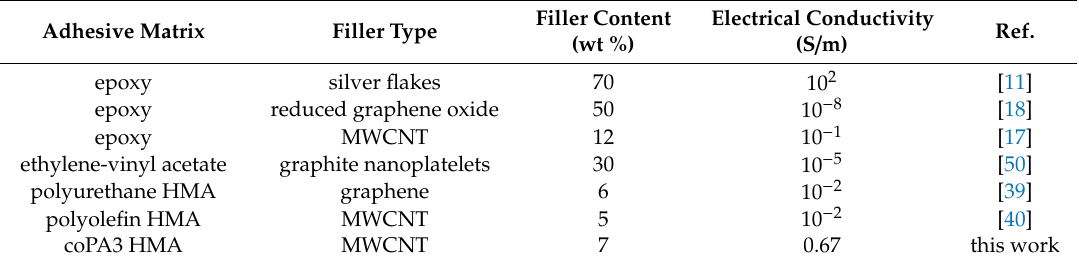
Table 3. Electrical conductivity in di ff erent types of electrically conductive adhesives